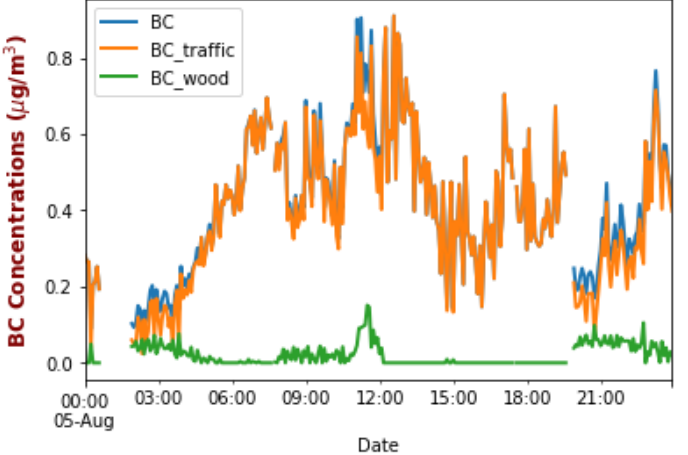
Figure 11. Temporal variation of the BC mass concentrations ( µ g/m 3 ) along with the contribution of the fossil fuel and wood burning to the total BC mass concentration on 5 August 2019.